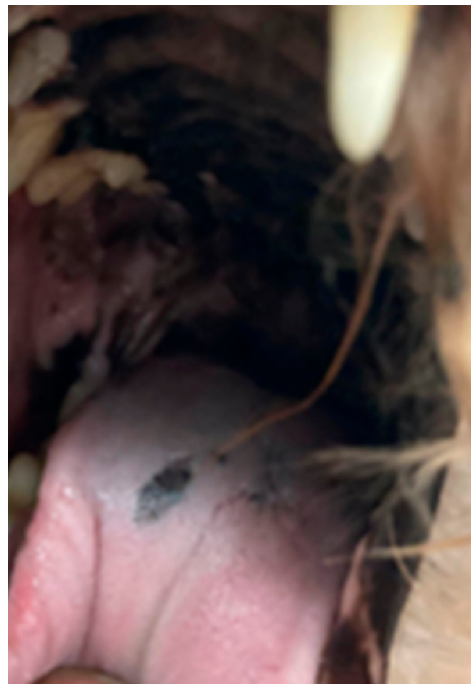
Figure A4. Appearance of the mass at final re-visit, 15 months after diagnosis.